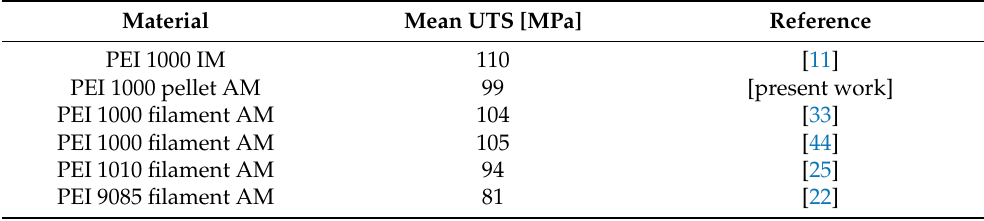
various sources, and therefore, cannot be directly compared.